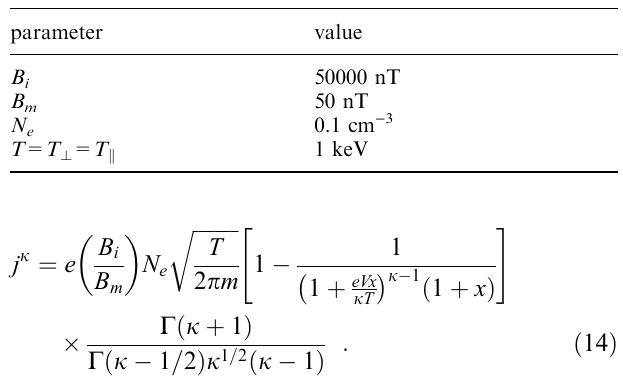
Fig. 3. Comparison of di(cid:128)erent (cid:106) values for the exact kappa current density formula; (cid:106) (cid:136) 2 ( dot ), (cid:106) (cid:136) 3 ( long-short-short dash ), (cid:106) (cid:136) 5 : 5 ( dash-dot ), (cid:106) (cid:136) 1 , i.e. Maxwellian ( solid )